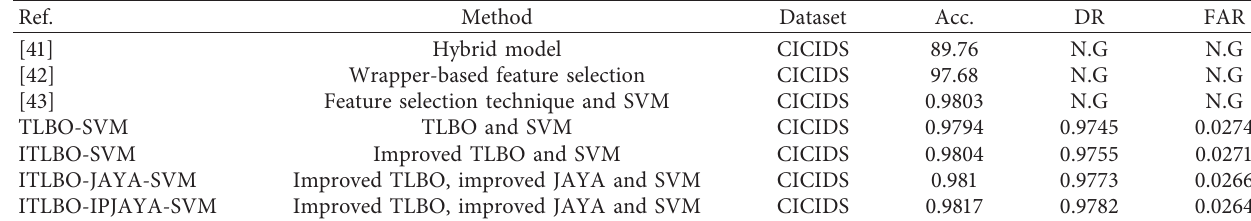
Table 15: Comparison with the existing work for the CICIDS 2017 dataset. Ref.